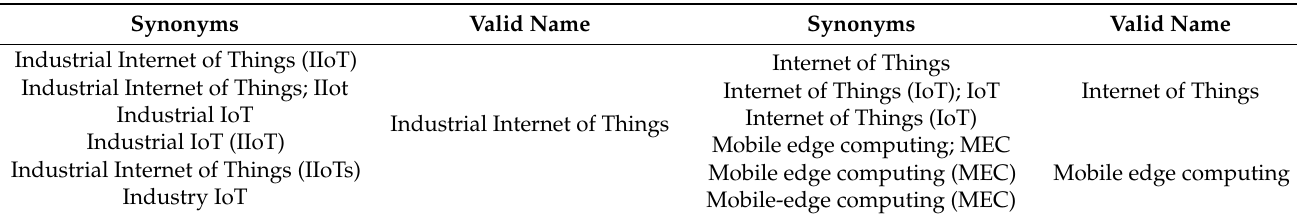
Table 3. The list of synonyms and their valid names.